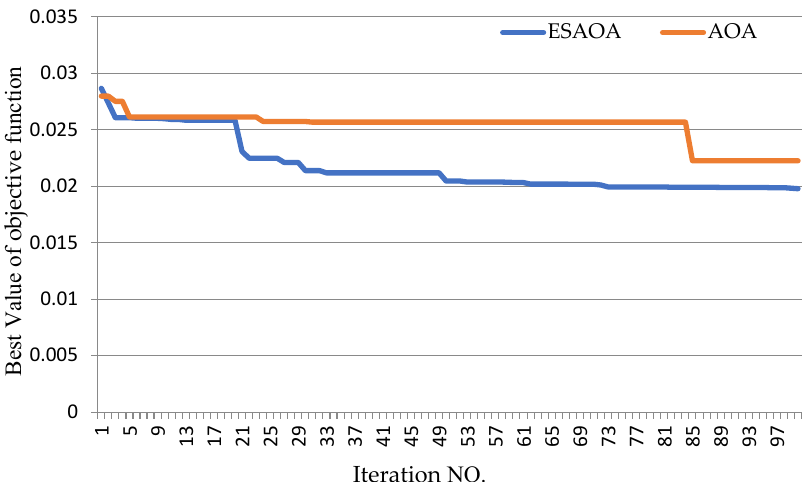
Figure 14. The convergence curve of the proposed PID controller using AOA and ESAOA techniques.